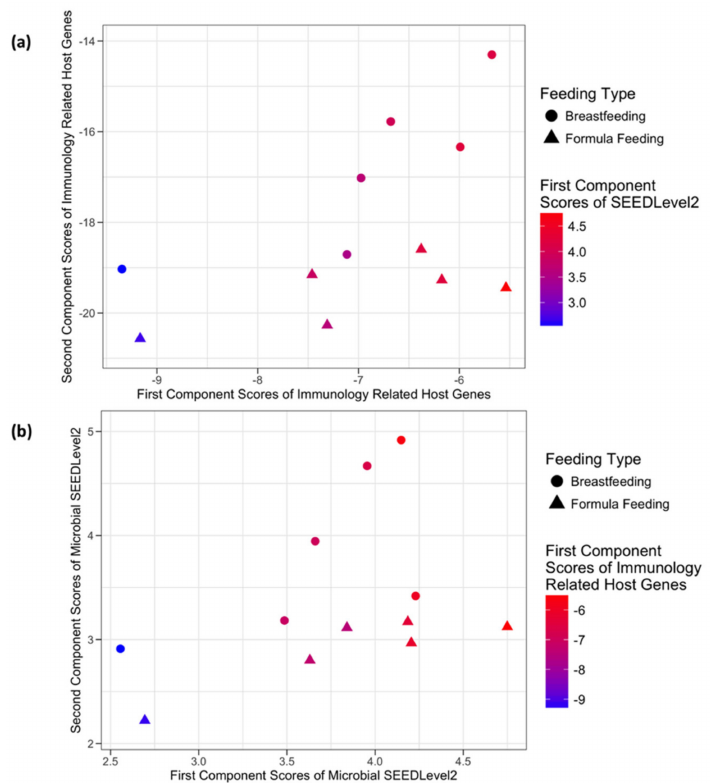
Figure 4. Sparse Canonical Correlation Analysis (sCCA) of immunology and defense related host genes and the microbial communities at SEEDLevel2. In panel ( a ), the x-axis and the y-axis represent the first and the second component scores from the normalized microarray expression of immunology and defense related host genes, respectively. The list of genes forming these two components is presented in Table S7a. Coloring of the sample points represents the first component scores from the microbial communities from the SEEDLevel2 subsystem. In panel ( b ), the x-axis and the y-axis represent the first and the second component scores from the normalized SEEDLevel2 subsystem of microbial communities, respectively. The list of SEEDLevel2 microbial categories forming these two components is presented in Table S7b. Coloring of the sample points represents the first component scores from the normalized microarray expression of the immunology and defense related host genes.